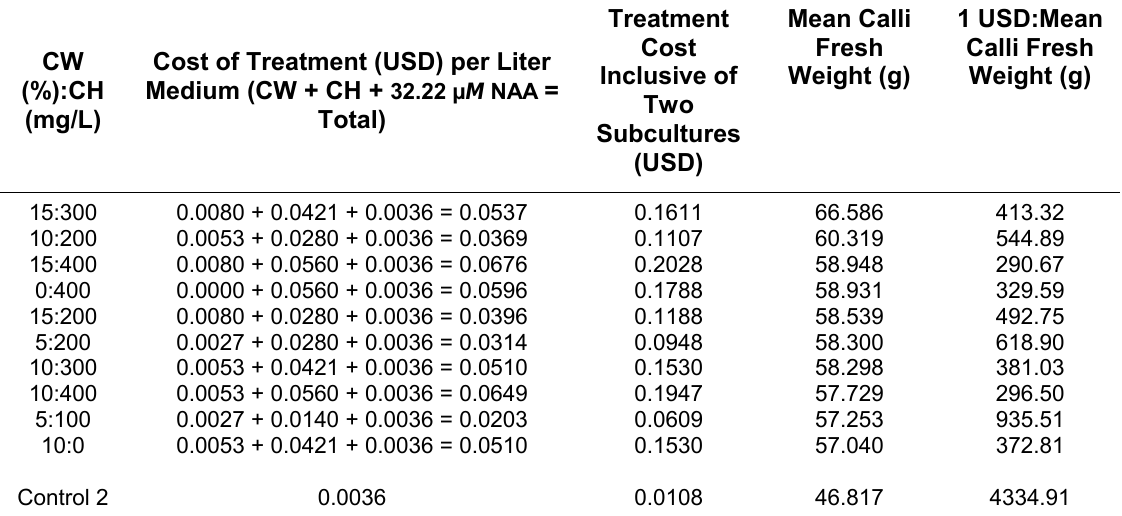
Production of Callus (Fresh Weight) of cv. Moris per USD as to Different